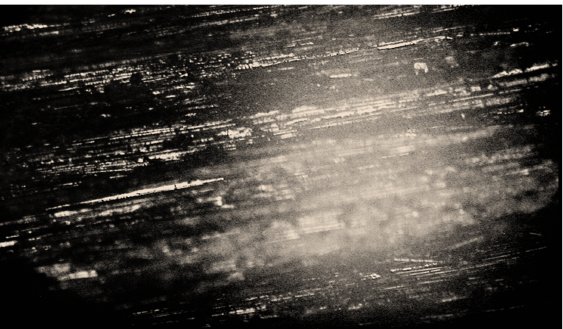
Figure 7. Image of a swelling of the binder in the damaged area of the BFRP rebar sample in contact with the soil, polarizing microscopy, × 1000